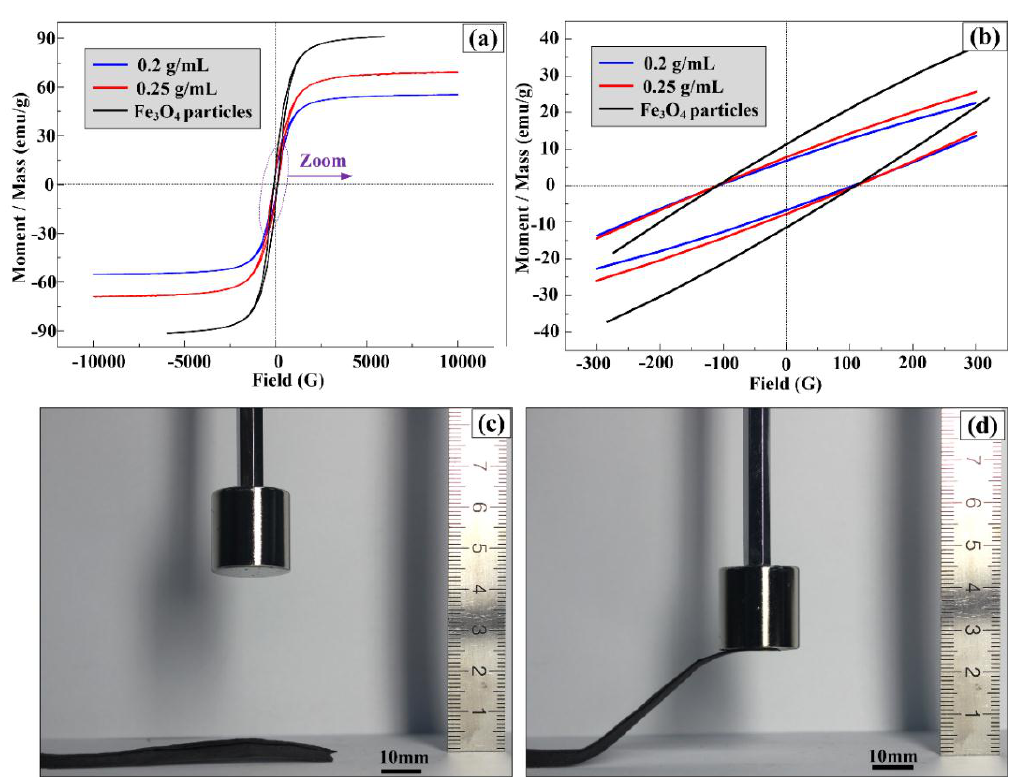
Figure 6. ( a ) Magnetic hysteresis loops of Fe 3 O 4 particles and PVP/Fe 3 O 4 membranes, ( b ) detailed view of the magnetic hysteresis loops at the origin, and ( c , d ) the magnetic field responsive behavior of PVP/Fe 3 O 4